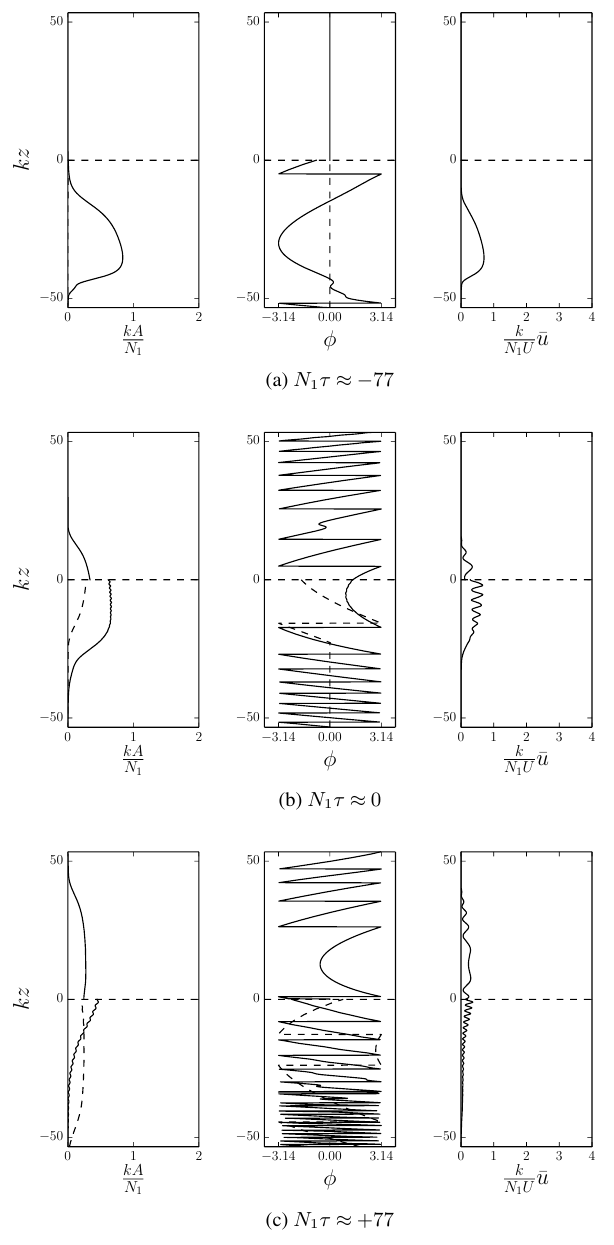
Figure 11. Vertical profiles of the wave magnitudes A (left panel), phases φ (center panel), and mean flow (right panel) at three times in two layers. The parameter values are n 1 /k = 1, N 2 /N 1 = 2, (cid:15) = 0.025, and α = 0.1. The line conventions are the same as Fig. 3.